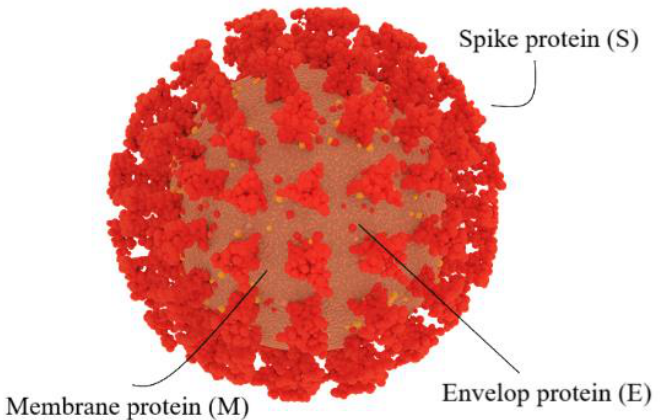
Figure 2. SARS-CoV-2 structure. Similar to other coronaviruses, SARS-CoV-2 contains a membrane (M) glycoprotein, an envelop (E) protein, a spike (S) protein, and a nucleocapsid (N) protein (not shown at the outer layer).